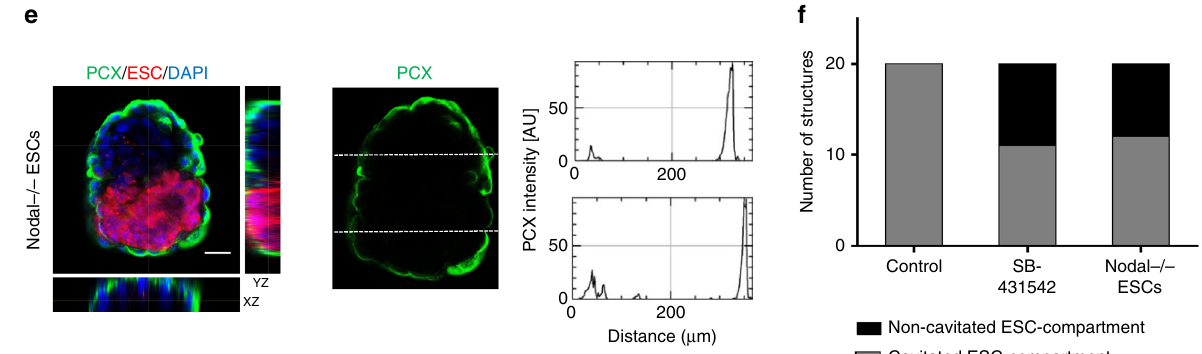
initially formed after 12 h of shaking culture (Supplementary Fig. 4a). Labeling EXE-embryoids for Podocalyxin (PCX), E-